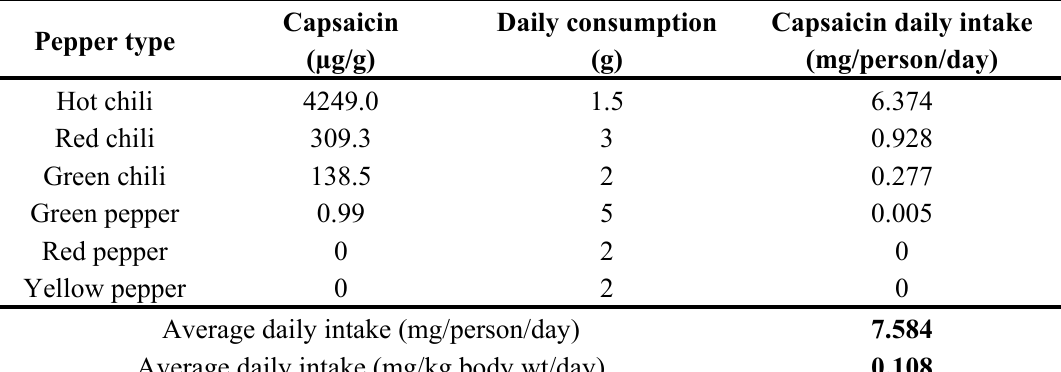
Table 3. Average capsaicin daily intake in correlation with